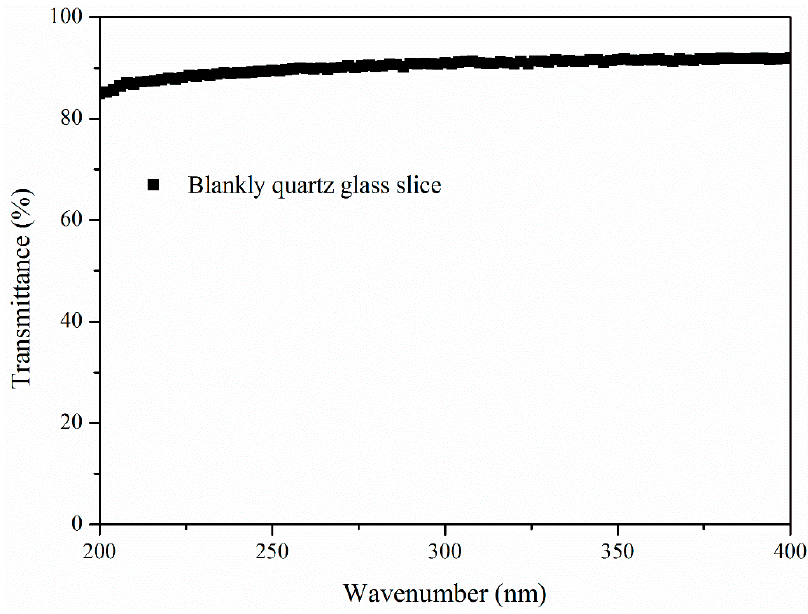
Figure 3. Transmittance of the blankly quartz glass slice with 1 mm thickness.